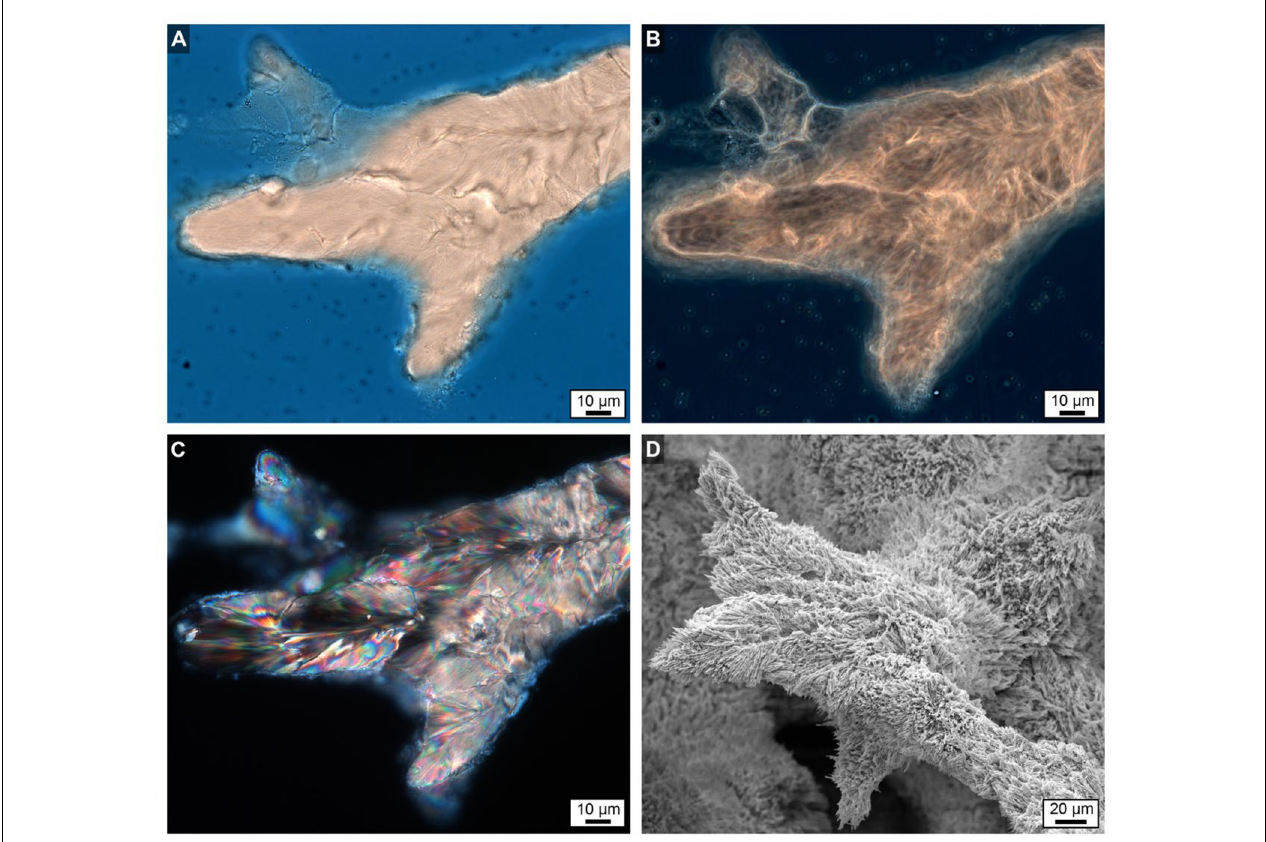
FIGURE 8 | Uppermost growing surface at the top of Core 3 showing finger-like skeletal growth projections. (A) Brightfield (BF) image. (B) Phase contrast (PC) image. (C) Polarization (POL) image. (D) Scanning electron microscope (SEM) image taken from a location only mm’s away with a strikingly similar morphology to the images shown in (A–C)